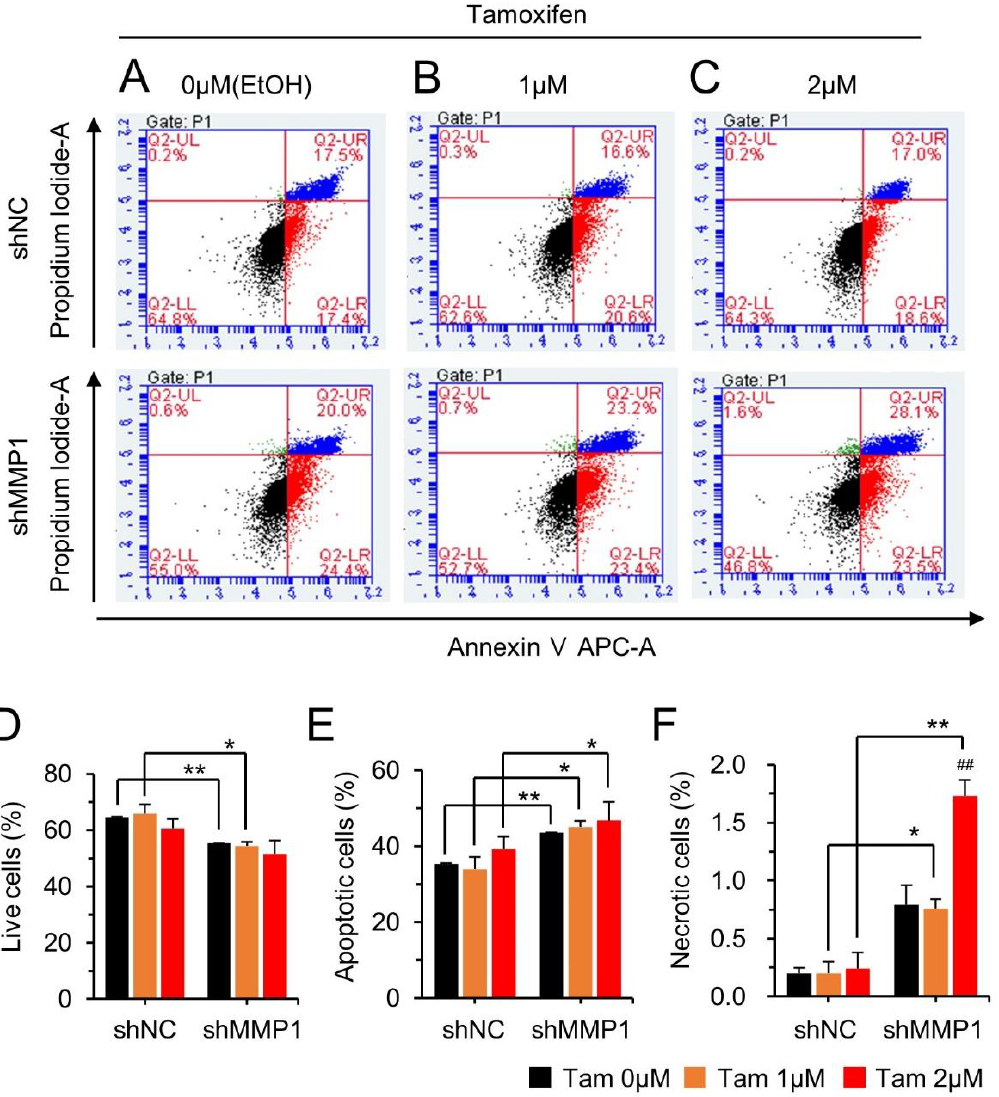
Figure 3. Effects of MMP1 on apoptosis and necrosis of MCF-7/tamR cells. Flow cytometry was performed after downregulating MMP1 with a stably expressed shRNA lentiviral vector. Repre- sentative flow cytometry images at 0 μM ( A ), 1 μM ( B ), and 2 μM ( C ) of tam are shown. Top and bottom images are for shNC and shMMP1, respectively. Cells in each quadrate of the FACS image represent, clockwise from the upper left, necrosis (green), late apoptosis (blue), early apoptosis (red), and live cells (black). Ratio of live cells ( D ), apoptotic cells ( E ), and necrotic cells ( F ) are shown in a bar graph. All assays were performed for three independent experiments, and data presented as mean ± SE. shMMP1, short hairpin RNA against MMP1; shNC, negative control shRNA. * p < 0.05, ** p < 0.01; ## p < 0.01 versus shMMP1 control.